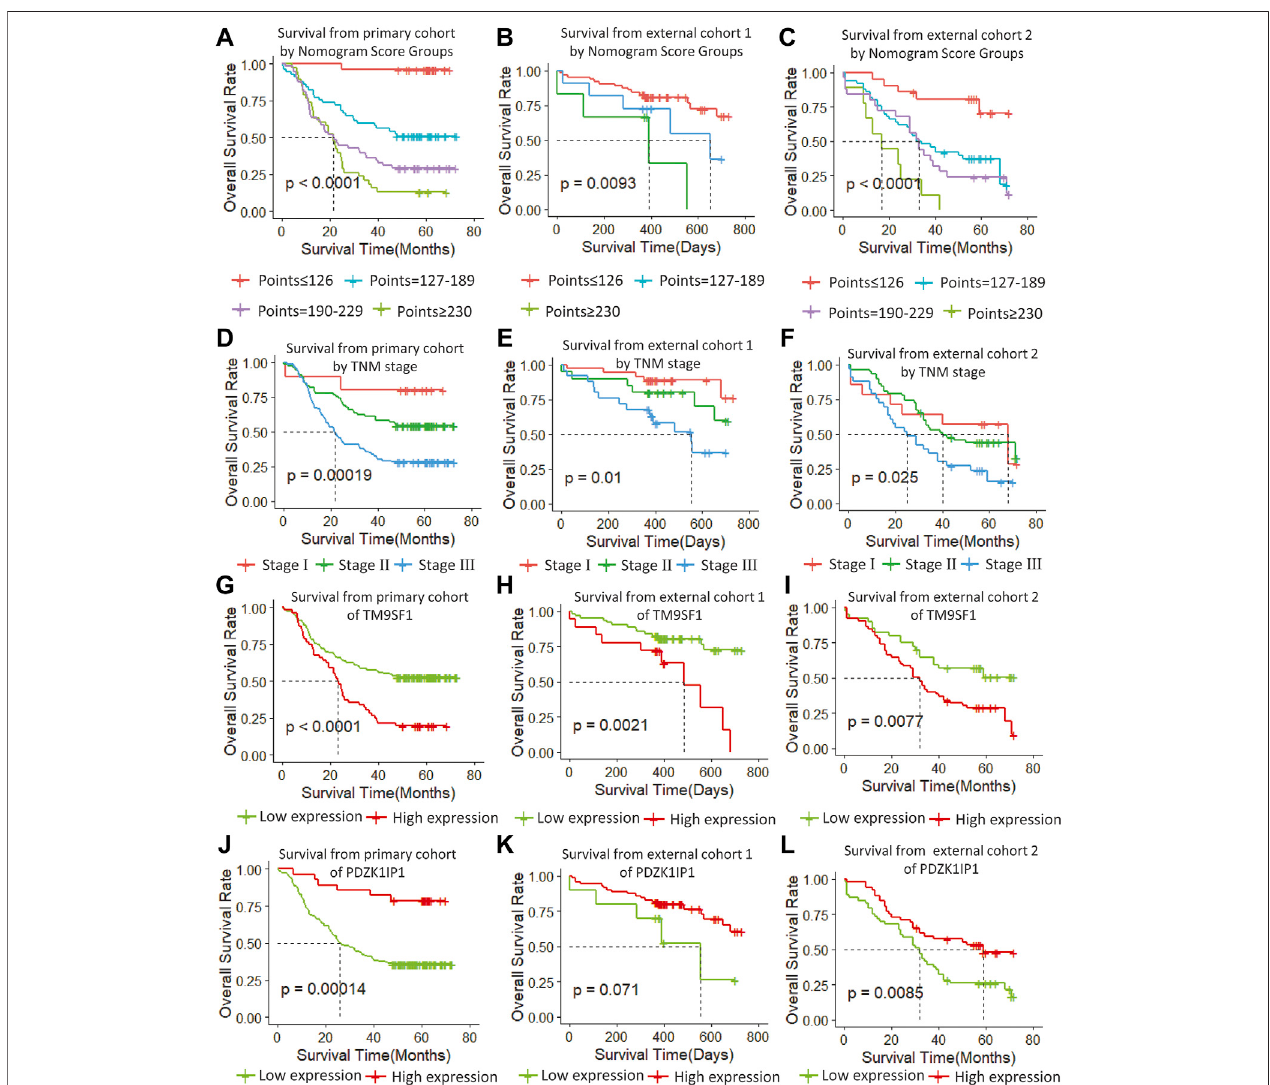
FIGURE 6 | (A – C) Survival from primary cohort by nomogram score groups, (D – F) survival from each cohort by TNM stage, (G – I) survival from each cohort of TM9SF1, and (J – L) survival from each cohort of PDZK1IP1.